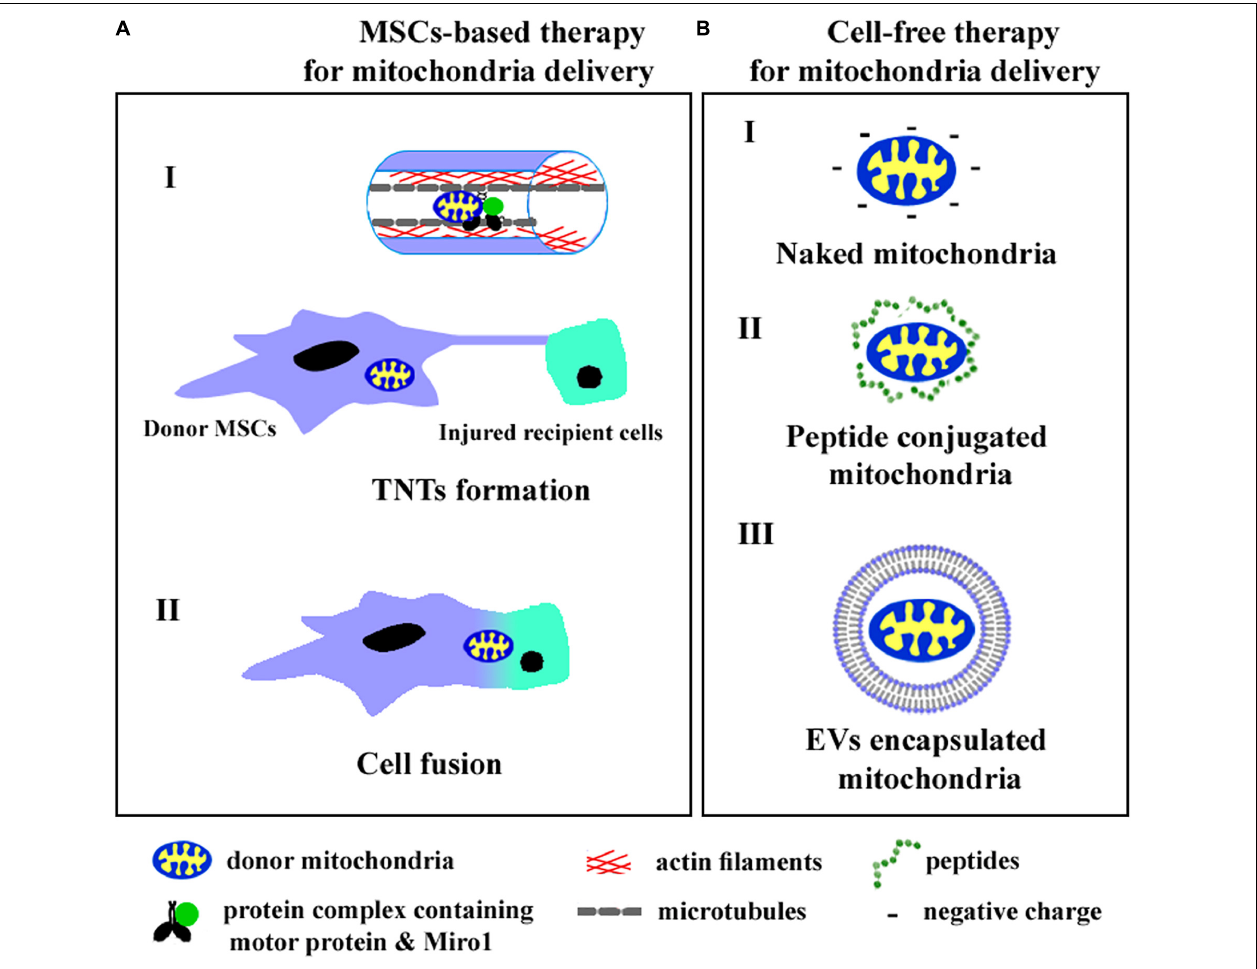
FIGURE 1 | The cell-based (A) and cell-free (B) strategies of mitochondria delivery into recipient cells. A (I) —mitochondria transfer through TNTs, A (II) —mitochondria exchange after cell fusion, B (I) —injection of isolated mitochondria, B (II) —application of peptide conjugated mitochondria, B (III) —delivery of mitochondria encapsulated into